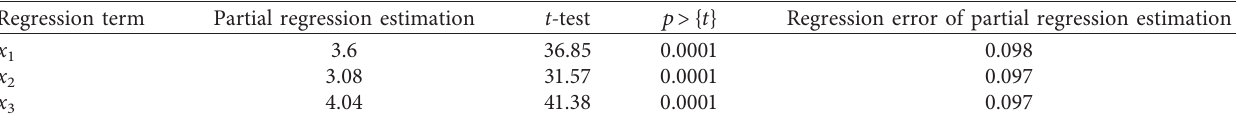
Table 11: Estimation of the partial regression coefficient of y modified with raw soil.